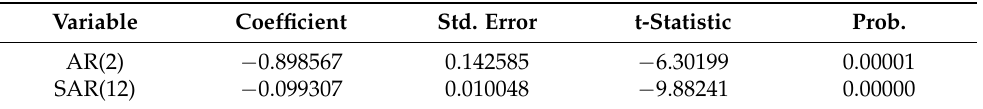
Table 8. Estimation of demand for dark tourism in C ó rdoba SARIMA (2,1,0) (1,1,0) 12 . Dependent